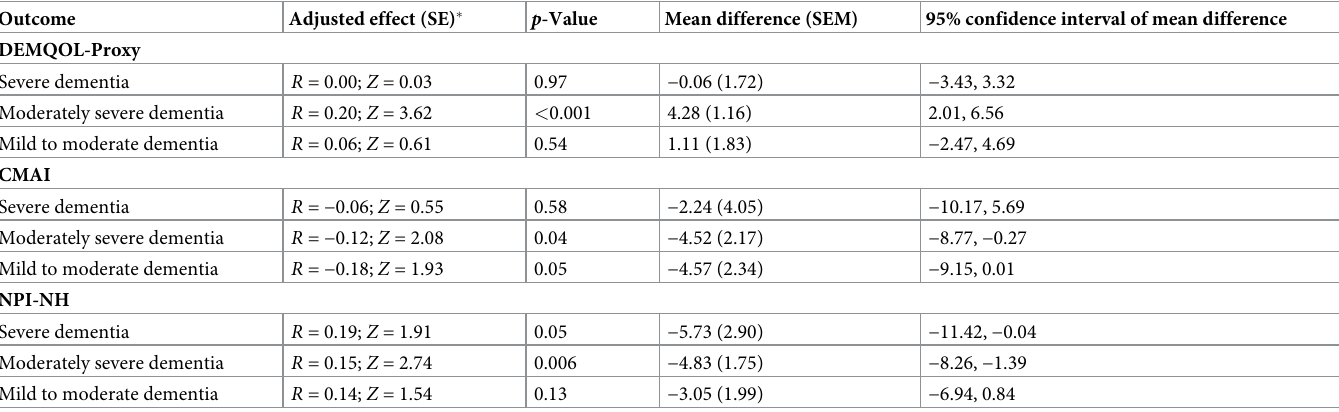
Table 3. Effect estimates of the WHELD intervention in comparison to treatment as usual for key outcome measures (multiple imputation analysis): Sub-analysis evaluating impact of WHELD in mild to moderate, moderately severe, and severe dementia.